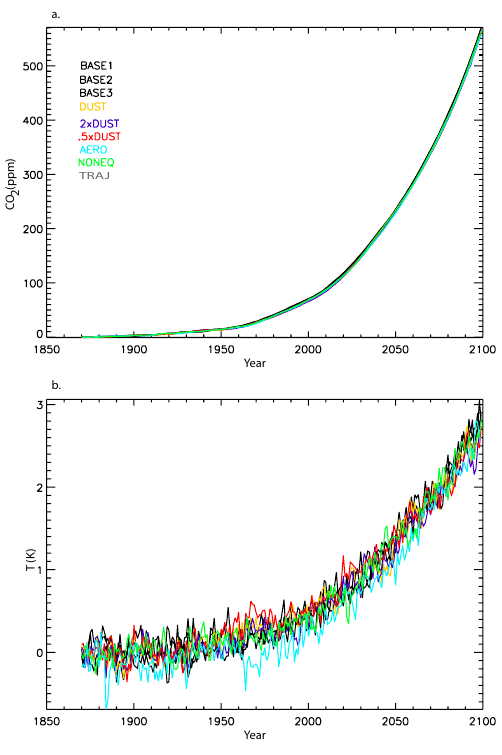
Fig. 1. Globally averaged change in CO 2 concentration (ppm) (a) and surface temperature (K) from the preindustrial control for the cases with CO 2 fully interactive from Table 1 from 1870 to 2100. All globally averaged CO 2 concentrations are averaged over the whole atmosphere in this paper.